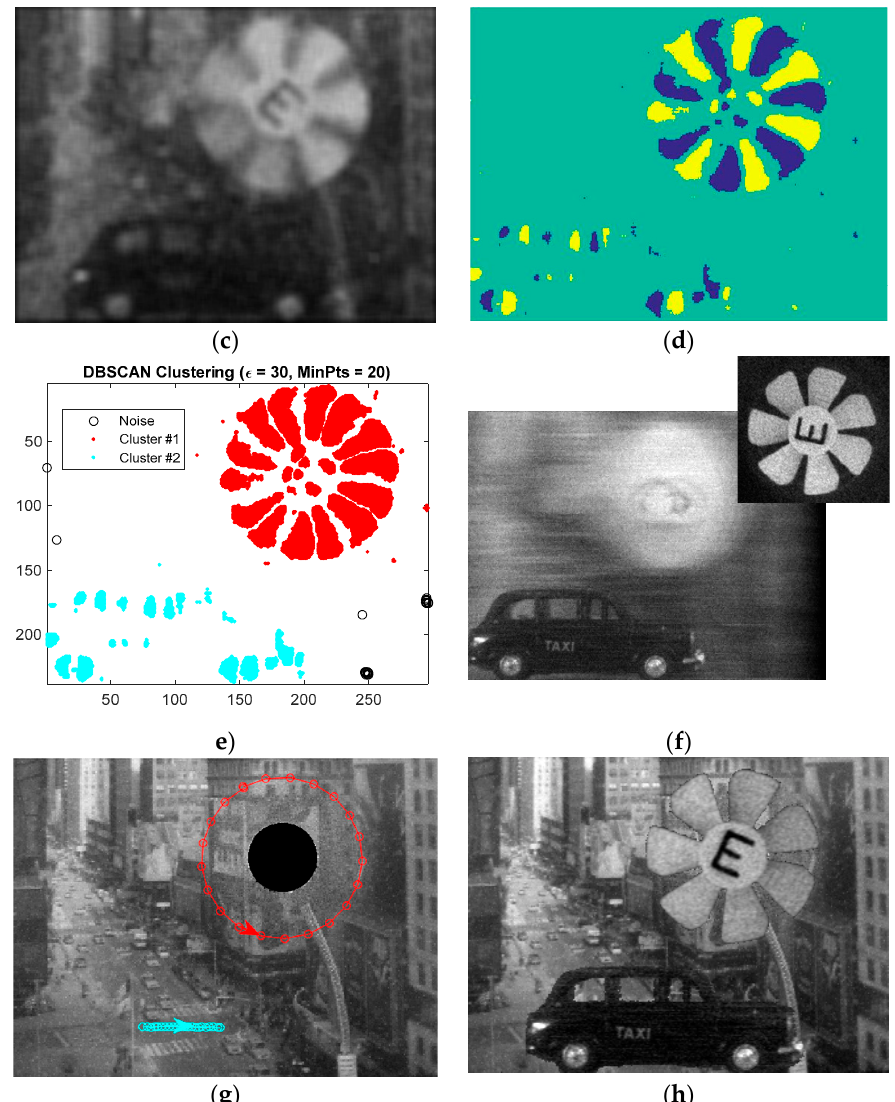
Figure 8. Results of fan and car test: ( a ) Single bit-plane exposure (100 µs); ( b ) Sum of N = 250 bit-planes (still frame from video rate image sequence, hot pixel compensation has been applied); ( c ) Test frame created by aggregating bit-planes using a kernel of size { N x , N y , N t } = {8, 8, 16}; ( d ) Difference frame computed from two test frames ( d = 2); ( e ) Result of DBSCAN clustering using [23]; ( f ) Reconstructed images of car and fan (from N = 250 bit-planes); ( g ) Reconstructed background with object trajectories, over one rotation of the fan, overlaid (each division representing 16 bit-planes = 1.6 ms); ( h ) Frame from final output sequence. We note the much-improved sharpness compared with image ( b ).